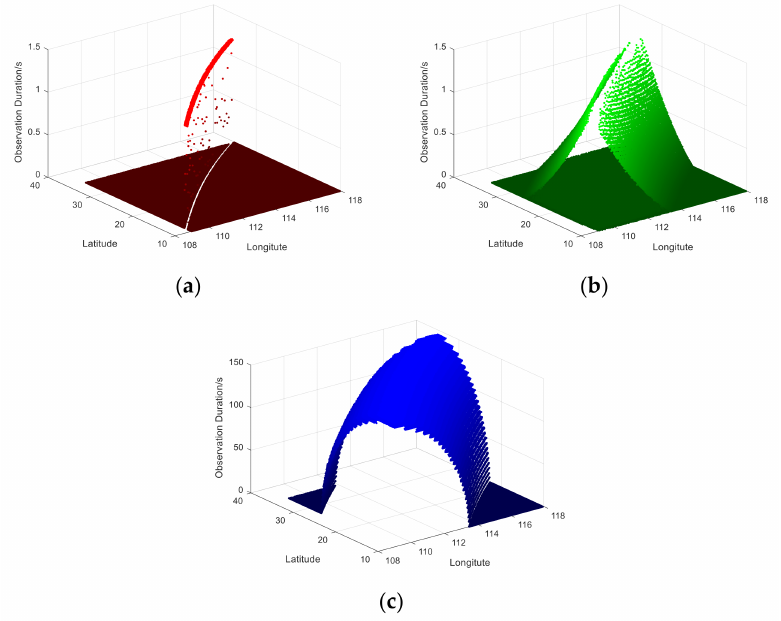
Figure 7. A diagram of the observation time duration. ( a ) Push broom; ( b ) Whisk broom; ( c ) Rotary scan.